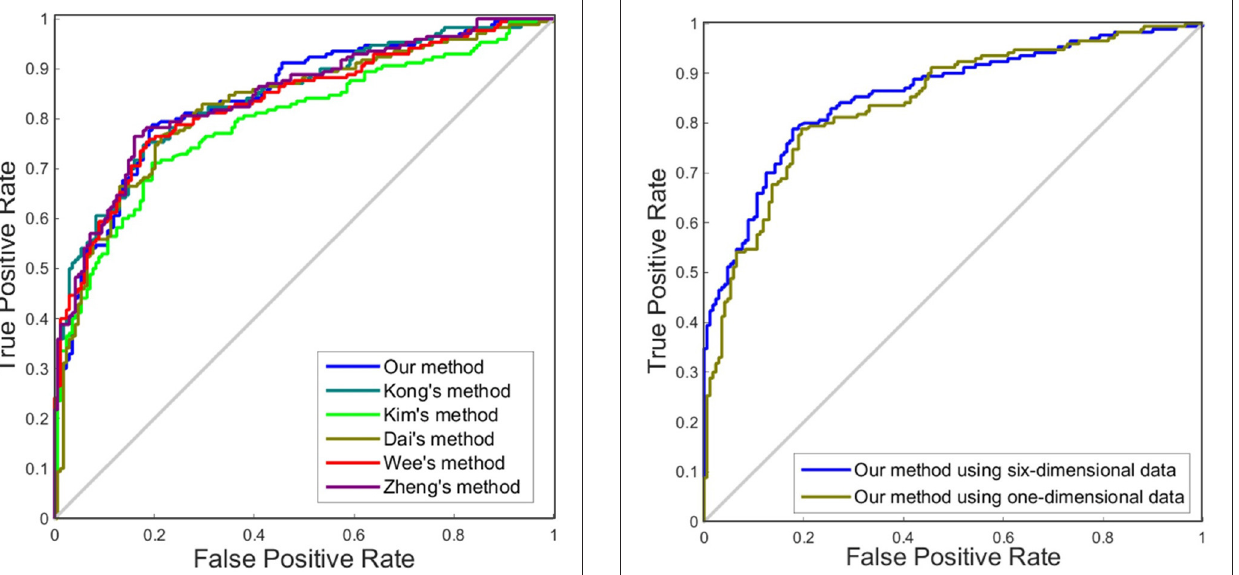
FIGURE 4 | ROC curves of different methods using one dimension to distinguish MCI and NC. The different line colors represent different methods to construct individual morphological brain networks based on cortical thickness. ROC, receiver operating characteristic.